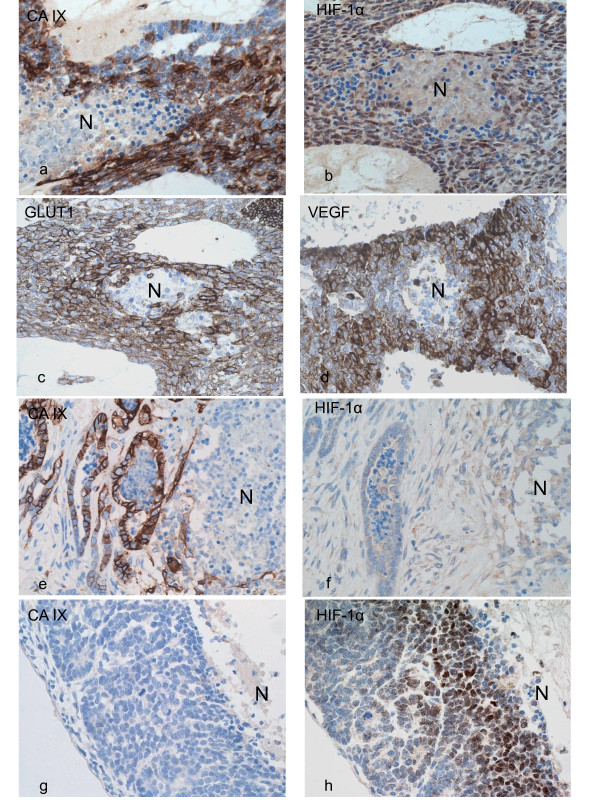
Immunohistochemical staining for CA IX (a, e, g), HIF-1α (b, f, h), GLUT1 (c) and VEGF (d) in WTs. Co-localisation of CA IX, HIF-1α, GLUT1 and VEGF in perinecrotic blastema (a-d). Perinecrotic tubules show CA IX but not HIF-1α expression (e, f). Perinecrotic blastemal cells are negative for CA IX, but nuclear expression of HIF-1α is present (g, h).